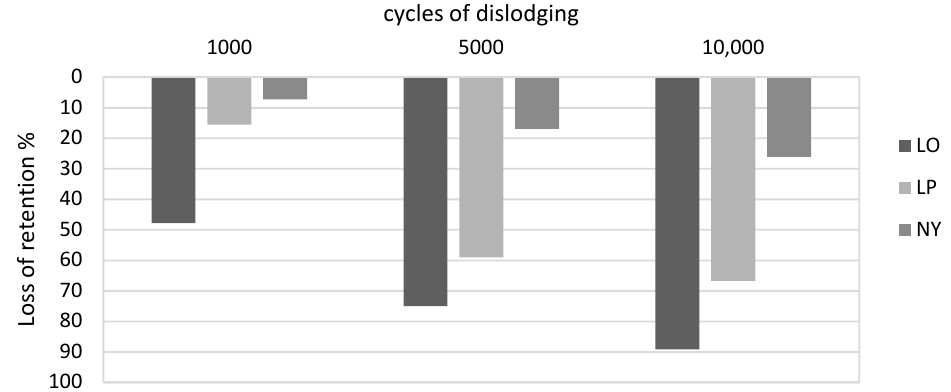
Figure 5. Figure 5 . Percentage retention force loss compared to the initial RFs, independent of the (implant) angulations.